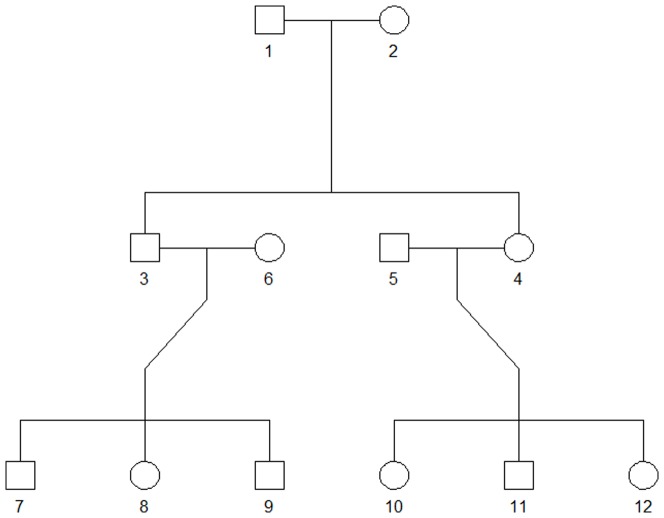
The family structure simulated by SeqSIMLA.